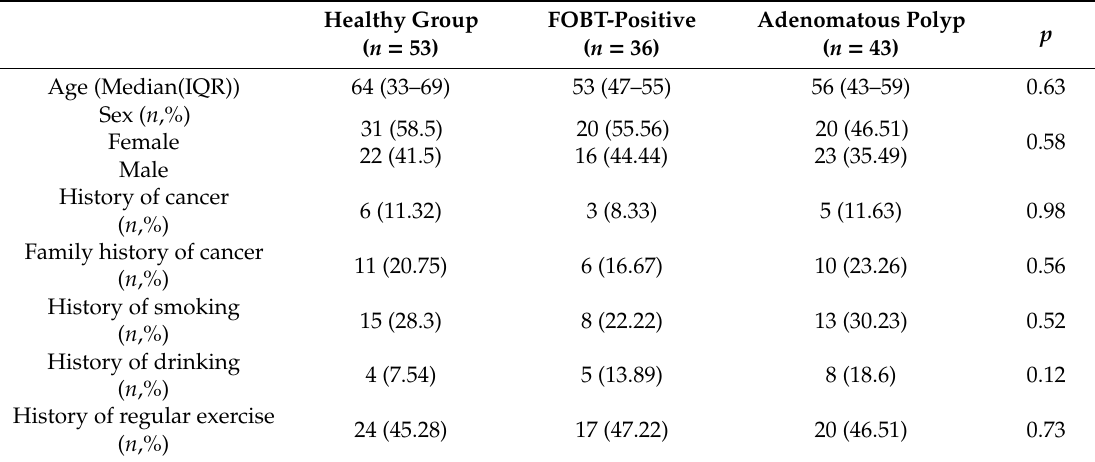
Table 1. Demographics of the healthy, iFOBT-positive, and adenoma groups.